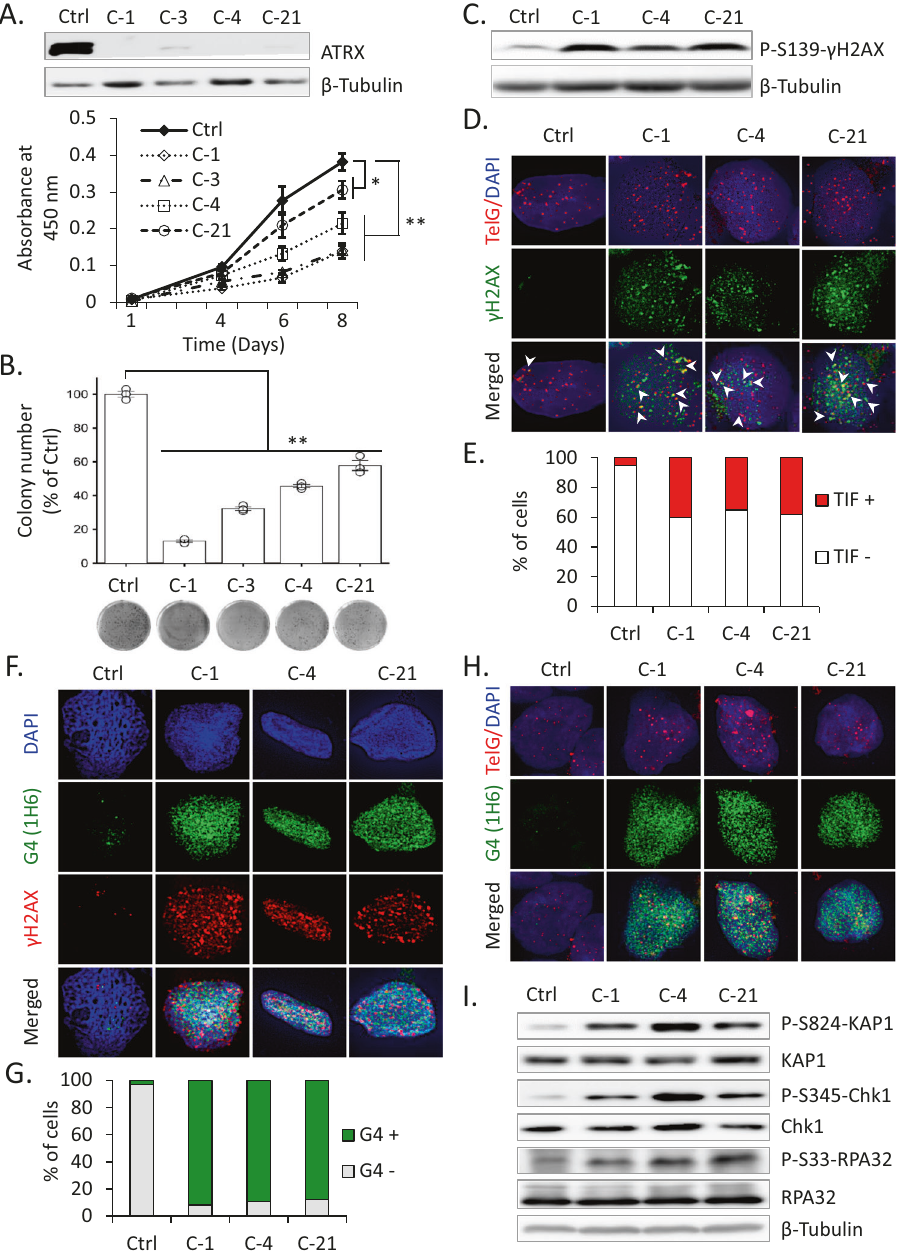
Fig. 1 ATRX loss induces G4 formation and RS in TP53 wt NGP cells. A Western blots show the depletion of ATRX protein expression in cell lysates prepared from Cas9 control (Ctrl) and ATRX KO (C-1, C-3, C-4, and C-21) NGP cells. β -Tubulin was used as a loading control. Lower panel, growth curves show that viability was lower in ATRX KO NGP cells than in Ctrl cells. Data are expressed as means ± standard deviation (SD), N = 3. A two-way ANOVA followed by a multiple comparison Bonferroni post hoc test was used to compare differences between groups (* p < 0.05 and ** p < 0.01). B Clonogenic assay of Ctrl and ATRX KO NGP cells demonstrating the weaker proliferative abilities of KO cells than Ctrl cells. Lower panel, representative images for clonogenic formation are shown. Error bars represent SD from three technical replicates. ** p < 0.01; A one-way ANOVA with Dunnett ’ s and Tukey ’ s test were used for statistical analyses. C Immunoblot showing activation of the DDR upon the depletion of ATRX, including the phosphorylation of histone H2AX on Ser-139 ( γ H2AX). D , E γ H2AX/TelG immuno-FISH ( D ) shows increased TIF (telomere dysfunction-induced foci) in ATRX KO NGP cells. Arrows denote the colocalization of telomeric foci (red) and γ H2AX signals (green). Cells were also stained with DAPI to visualize nuclei (blue). E Quanti fi cation of TIF + cells among 100 cells analyzed in ( D ). F , G Coimmuno fl uorescence staining of ATRX -intact (Ctrl) and ATRX KO NGP cells with the anti-G-quadruplex (G4) antibody, 1H6 and anti- γ H2AX. G Quanti fi cation of G4 + cells among 100 cells analyzed in ( F ). H G4 (1H6)/TelG immuno-FISH reveals colocalization of G4 on telomeric region in ATRX KO NGP cells. Nuclei are counterstained with DAPI (blue). I Representative immunoblot analysis of p-KAP1 (Ser-824), KAP1, p-Chk1 (Ser-345), Chk1, p-RPA32 (Ser-33), and RPA32, showing the activation of RS arising from ATRX de fi ciency. β -Tubulin served as a loading